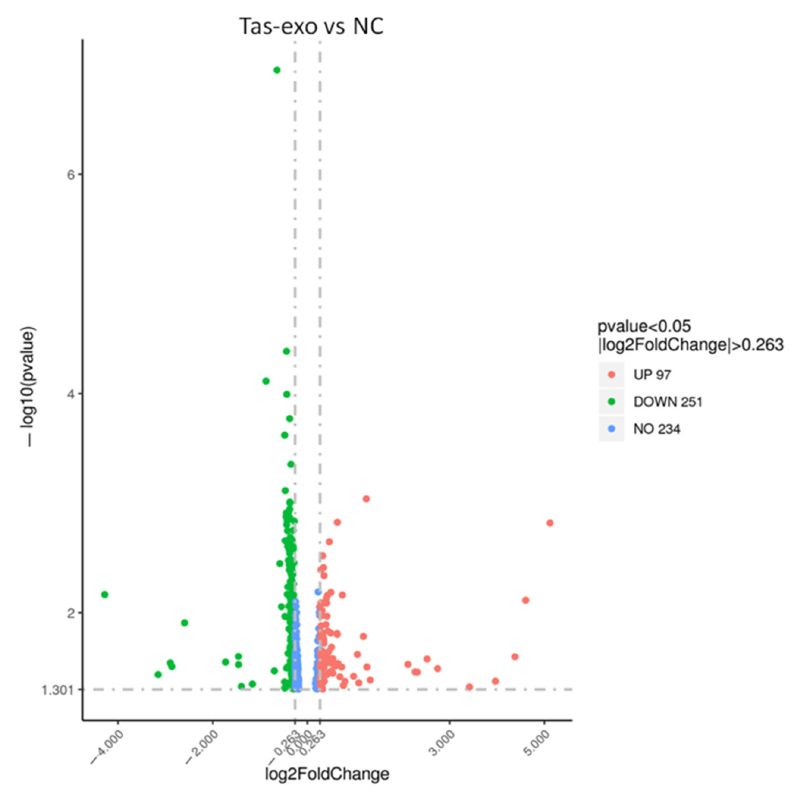
Figure 1. Volcano plot of global differentially expressed genes (DEGs). Red dots (up), significantly upregulated genes ( P < 0.05, fold change > 1.2); green dots (down), significantly downregulated genes ( P < 0.05, fold change > 1.2).